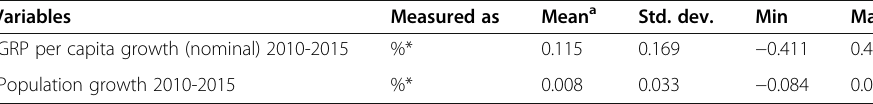
Table 1 Variables included in the cluster analysis, n = 60 Variables Measured as Mean a Std.